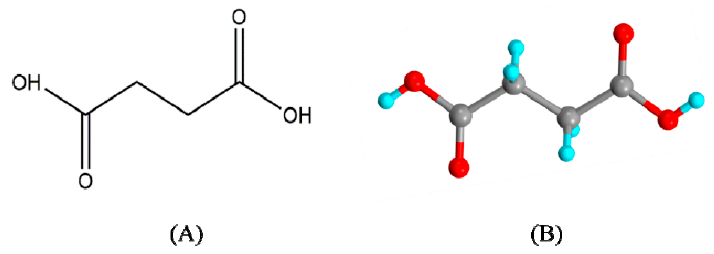
Figure 17. ( A ) Chemical structure of succinic acid ( A ) 2d and ( B ) 3d [175].